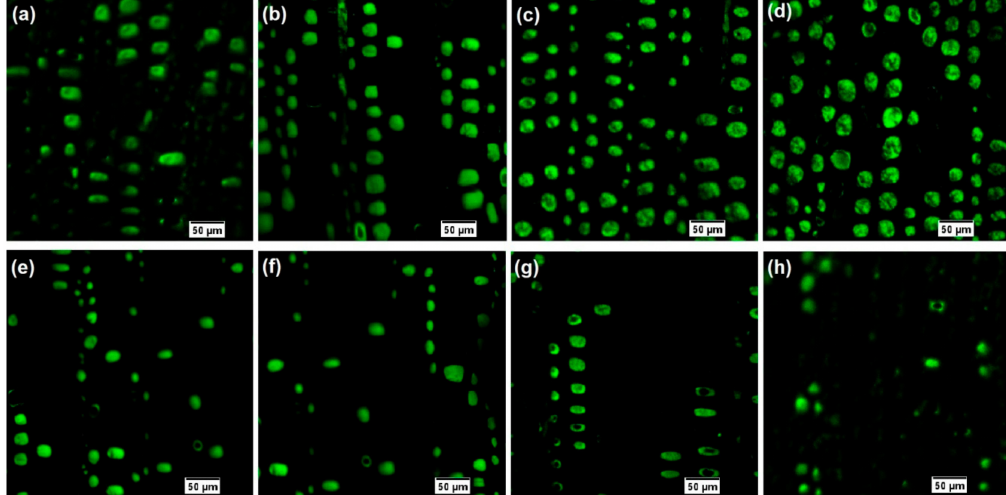
Figure 4. Typical confocal laser scanning microscopy (CLSM) microphotographs of the cured PF resin trapped in the wood tracheids: ( a – d ) PF resin with the concentrations of 15%, 20%, 25%, and 30% in the outer layer of wood, respectively. ( e – h ) PF resin with the concentrations of 15%, 20%, 25%, and 30% in the inner layer of wood, respectively. Cured PF resins in the lumen of tracheids are showed in green